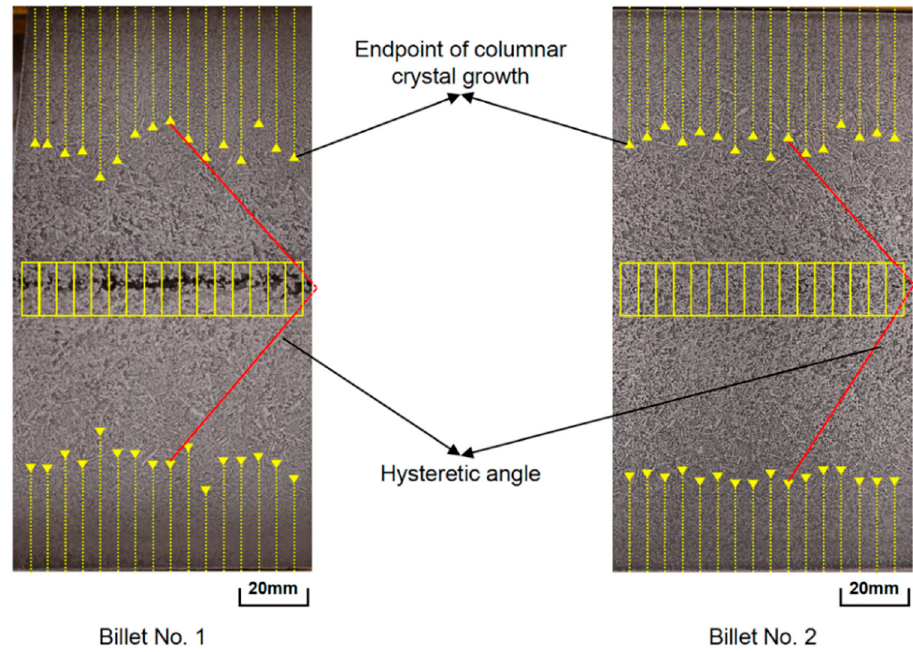
Figure 9. Hysteretic angles of billet No. 1 and No. 2. The yellow triangle symbols represent the determined CET position at each position corresponding to the central analysis areas.